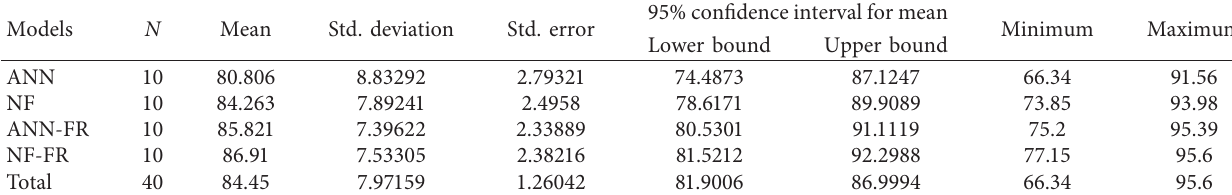
Table 6: ANOVA test with descriptive